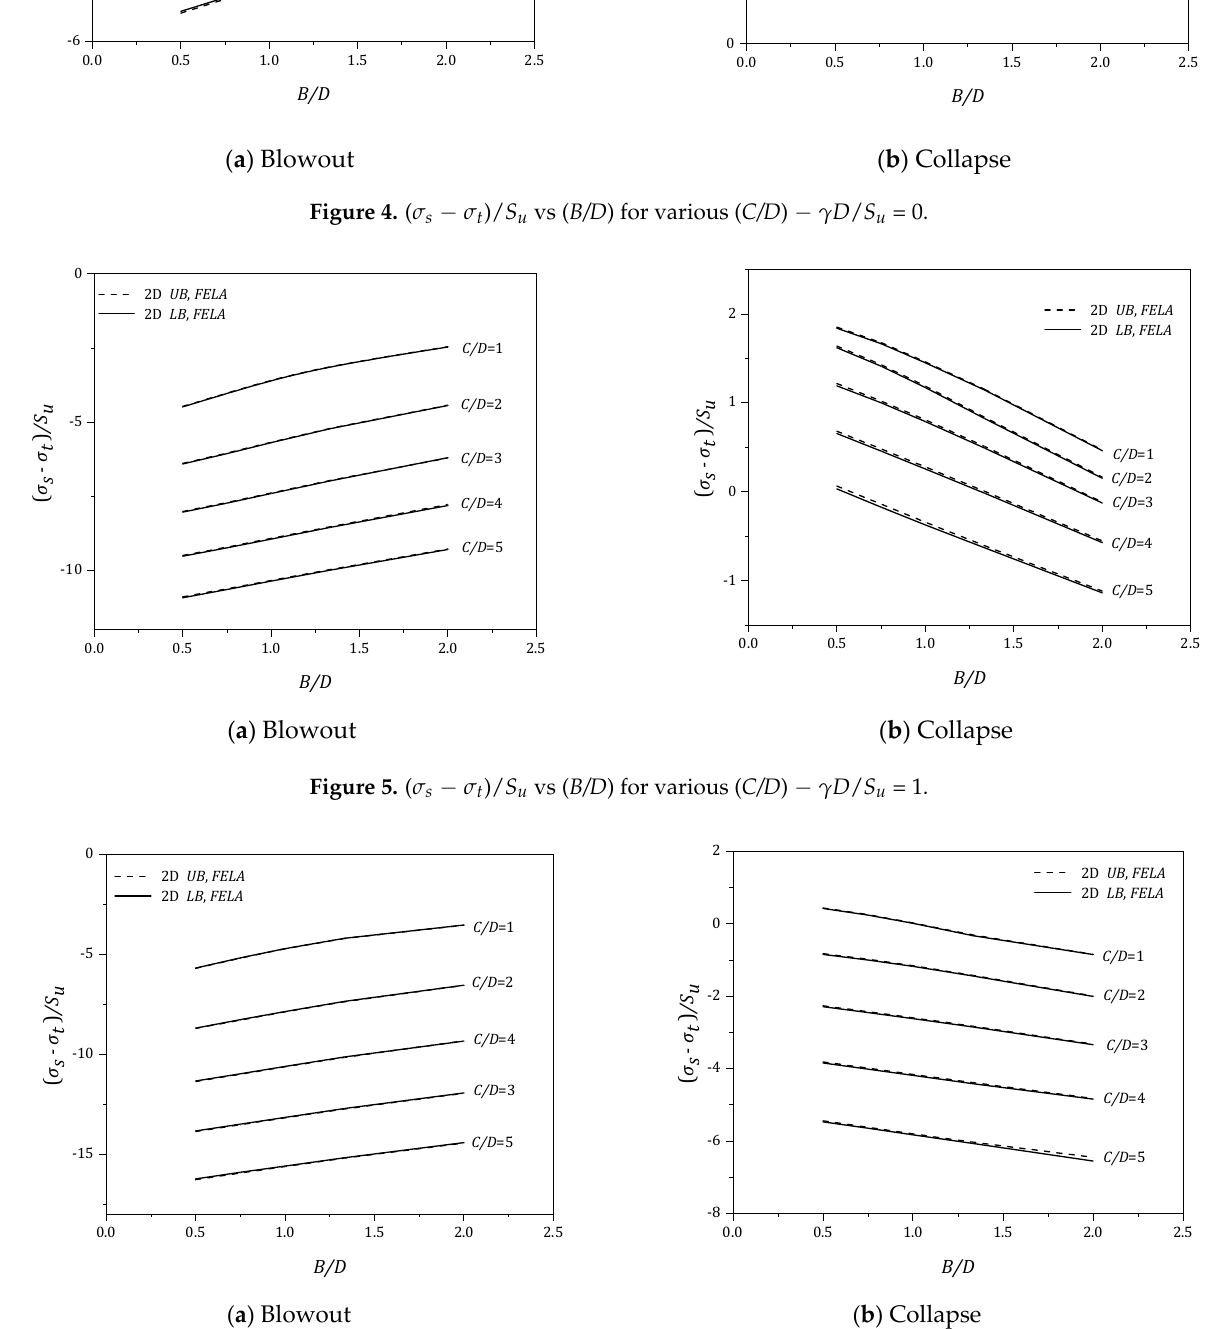
( b ) Collapse Figure 7. ( σ s − σ t )/S u vs ( B/D ) for various ( C/D) − γ D/S u = 3. Using the same data, the effects of ( C/D ) are presented in Figures 8–12. In general, for the blowout scenario (Figures 8a–12a), the absolute values of the pressure ratio { PR = ( σ s − σ t )/S u } increases as ( C/D ) increases. Note that the rate of increase (in negative PR ) is greater as ( γ D/S u ) increases. The finding is applicable to the various values of ( B/D ) of the blowout cases. Similar trends can be found in the collapse scenario (Figures 8b–12b), where larger σ t (in negative PR ) is expected to support the soil as ( γ D/S u ) increases. Furthermore, the larger the ( C/D ), the larger the σ t (in negative PR ) is. Design charts for assessing the blow- out and collapse stability for various strength ratios ( γ D/S u = 0–3) are presented in Figures 13–16, in which the x-axis represents the width to height ( B/D ) and the y-axis represents the depth ratio ( C/D ). One would need to input the “designed” parameters ( B/D ) and ( C/D ) to obtain a critical pressure ratio ( PR ) directly from the charts.